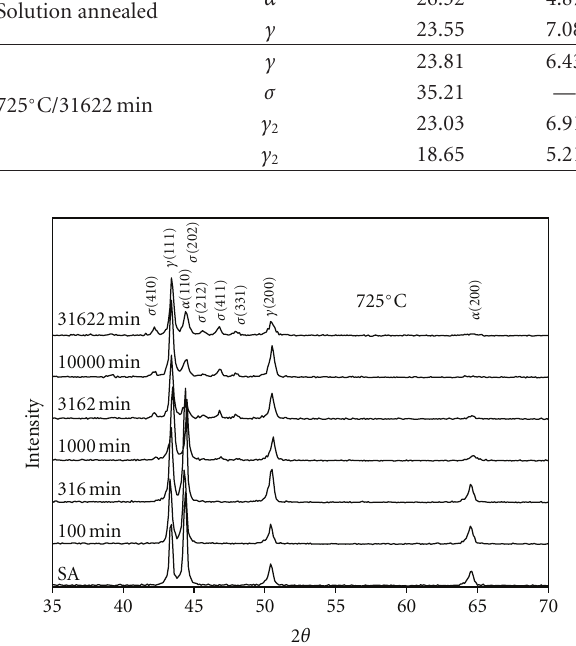
Figure 6: X-Ray di ff raction patterns of samples aged at 725 ◦